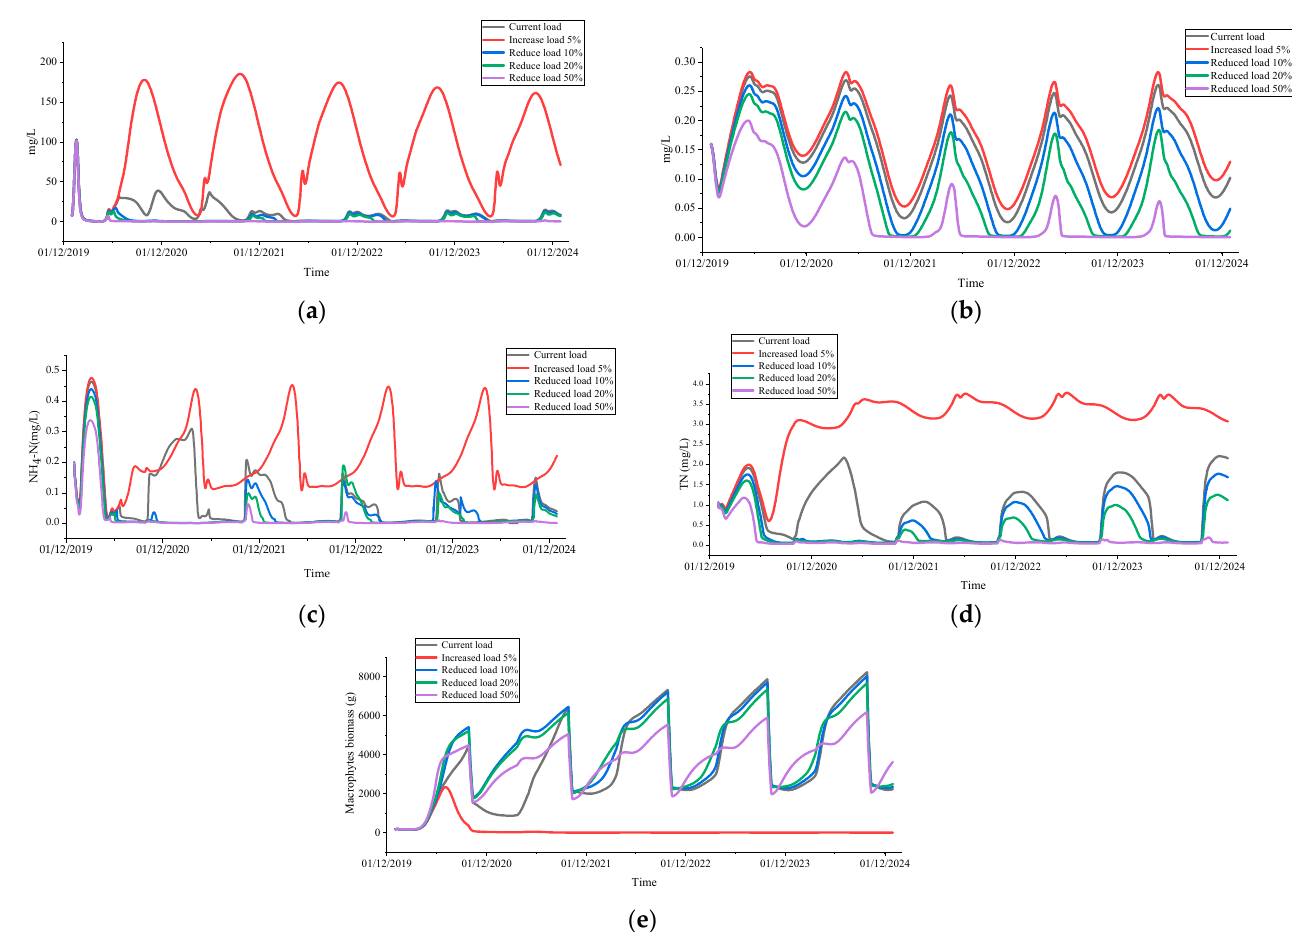
Figure 10. Simulations of decreasing and increasing nutrient loading in Lake Datong at the current load (brown lines), a 5% increased load (red lines), a 10% reduced load (blue lines), a 20% reduced load (green lines), and a 50% reduced load (purple lines) for the following factors: ( a ) chlorophyll a (Chl- a ), ( b ) total phosphorus (TP), ( c ) ammonium nitrogen (NH4 + -N), ( d ) total nitrogen (TN), and ( e ) macrophytes biomass.